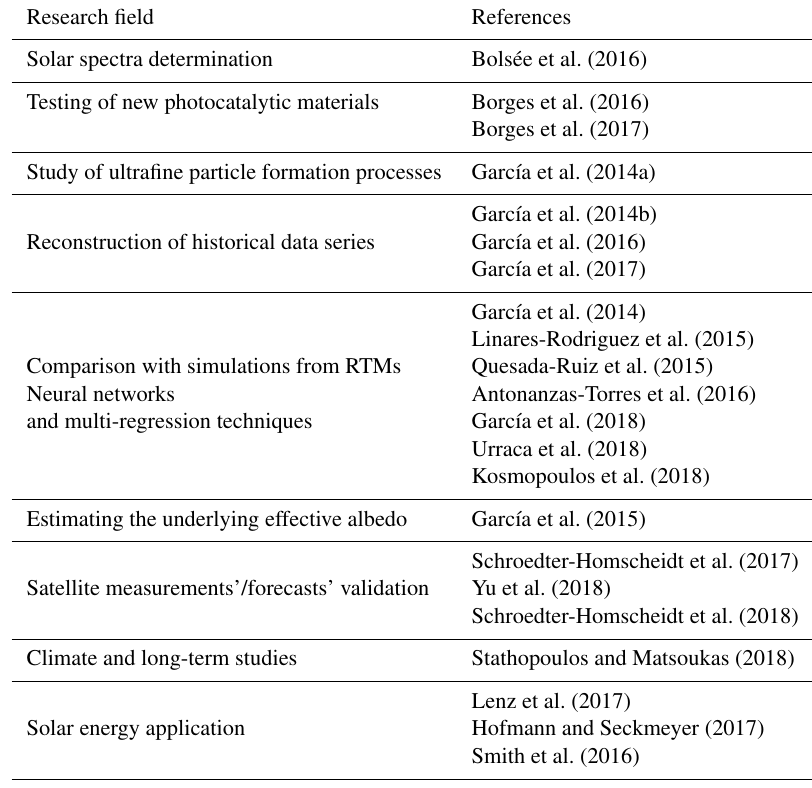
Table 8. Publications that used the IZA BSRN data in the last 5